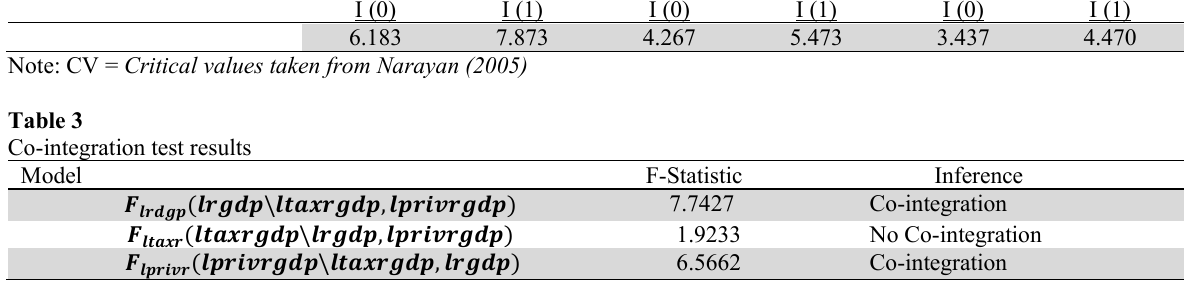
Critical value bounds of F-Statistic; intercept and no trend K=2 CV